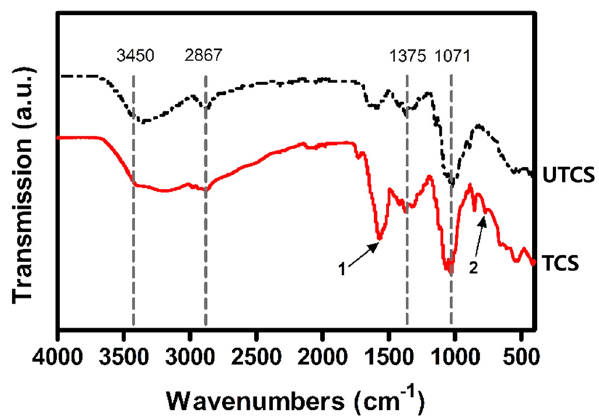
Figure 2: FTIR spectra of the chitosan dressing before and after optimization.